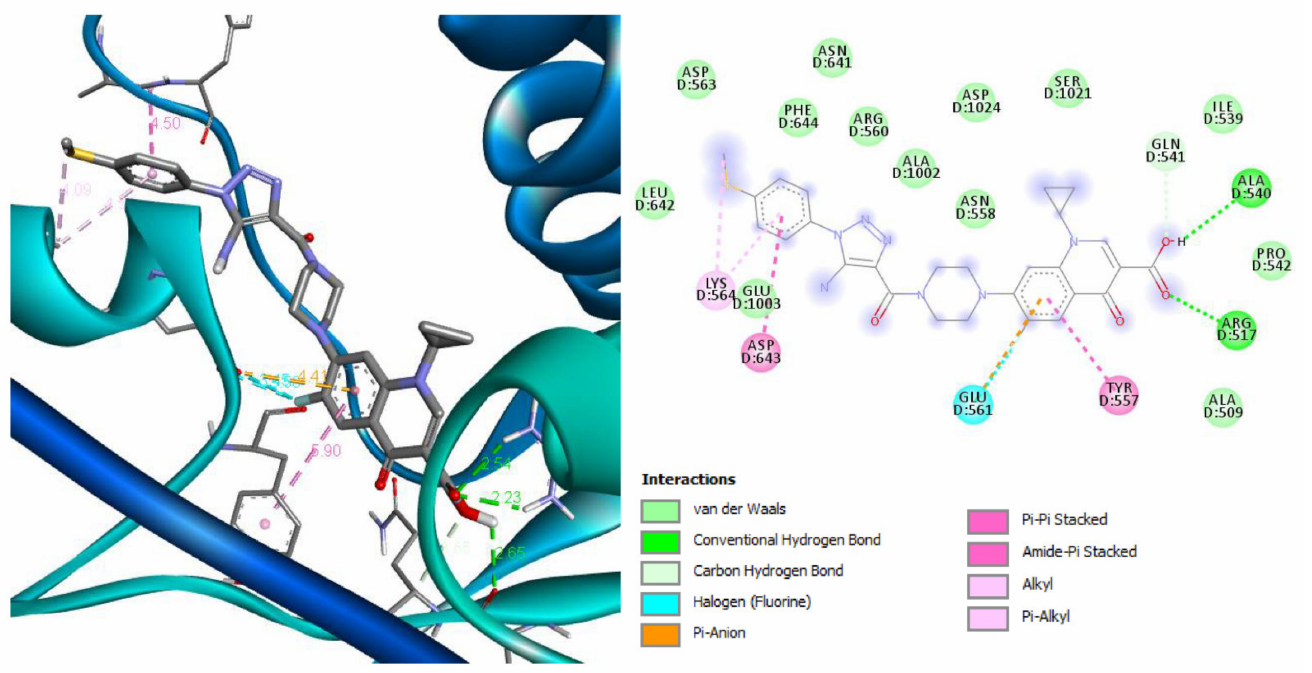
Figure 5. Superposition of compound 2h and diagram of intermolecular interactions in complex with DNA gyrase Staphylococcus aureus (PDB ID: